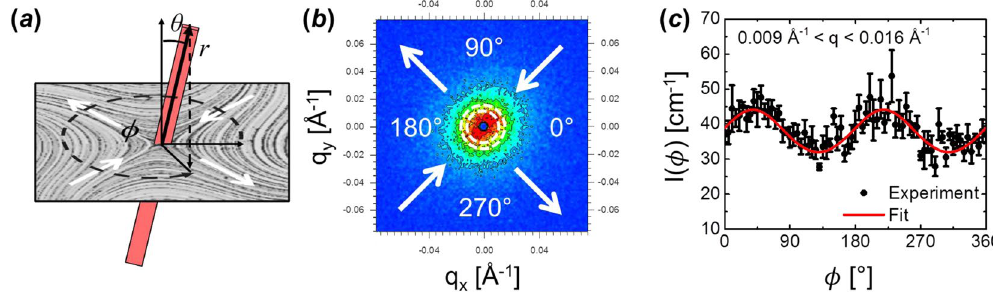
Figure 11. ( a ) Spherical coordinate system defined relative to the velocity-velocity gradient plane for FFoRM-SANS experiments. ( b ) 2D scattering pattern from a FFoRM-SANS experiment with 〈 Λ 2D 〉 = 0.95 and 〈 Pe r 〉 = 10. Colors correspond to the intensity at ( q x , q y ) with blue corresponding to low intensity and red corresponding to high intensity while black lines indicate contours of constant intensity. Region included in the annular average (0.009 Å − 1 < q < 0.016 Å − 1 ) is outlined in white. Inflow and outflow directions are indicated with white arrows. ( c ) Annular averaged scattering intensity profile (black points) as a function of the azimuthal angle φ defined relative to the positive q x -direction. The included fit is to the Maier-Saupe function with parameters determined using a nonlinear least squares fitting